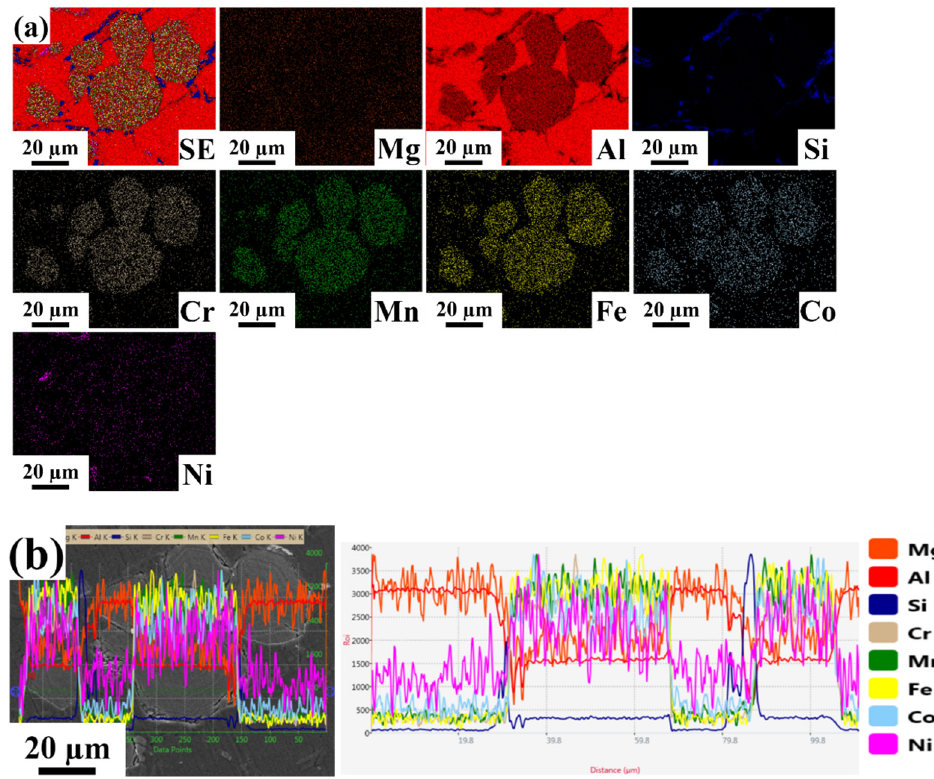
Figure 5. Energy dispersive spectroscopy images of LM25–5 wt.% HEA ( a ) Elemental mapping images. ( b ) Line scan image.